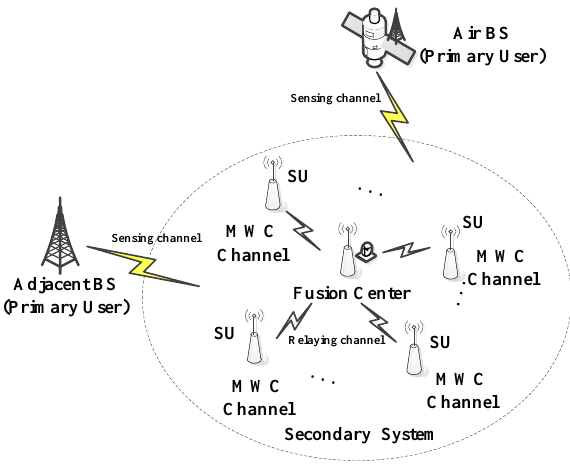
Figure 2. System